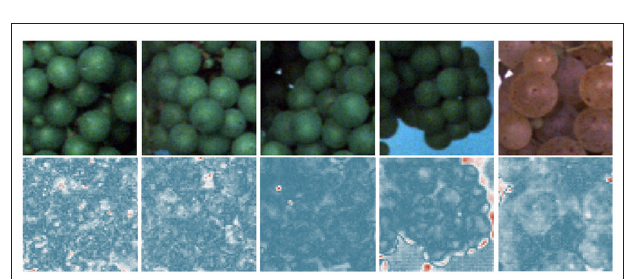
FIGURE 8 | Results for pixel-wise anomaly detection obtained by an FPL-VAE for healthy patches. The original images are displayed in the upper row. A corresponding heatmap of loss values is displayed in the lower row, where a red color represents anomalies and dark blue indicates